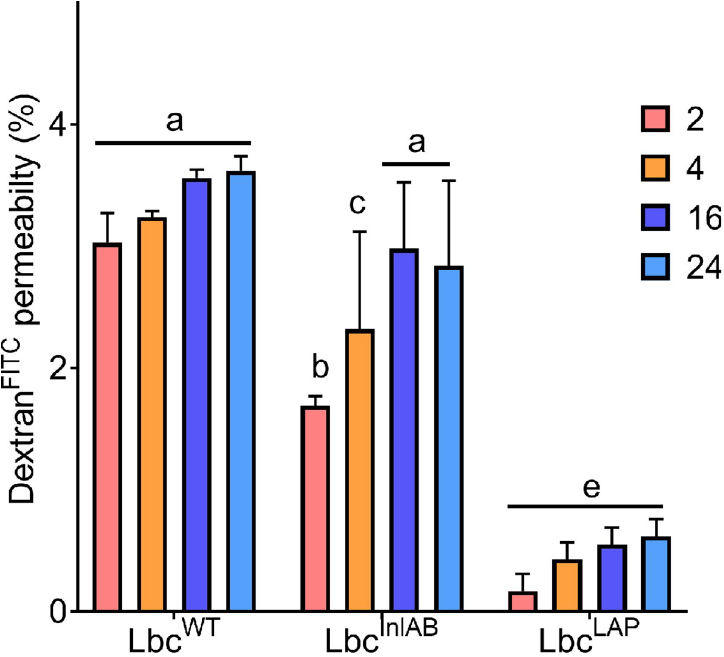
Fig 6. Tight junction integrity analysis using Dextran FITC permeability assays. Dextran FITC recovery after exposure to L . monocytogenes alone was 3.72 ± 0.03%. Bars marked with different letters (a, b, c, d, e, f) indicate significant difference at p < 0.05, error bars are standard deviations of average Dextran FITC recovered from the three independent